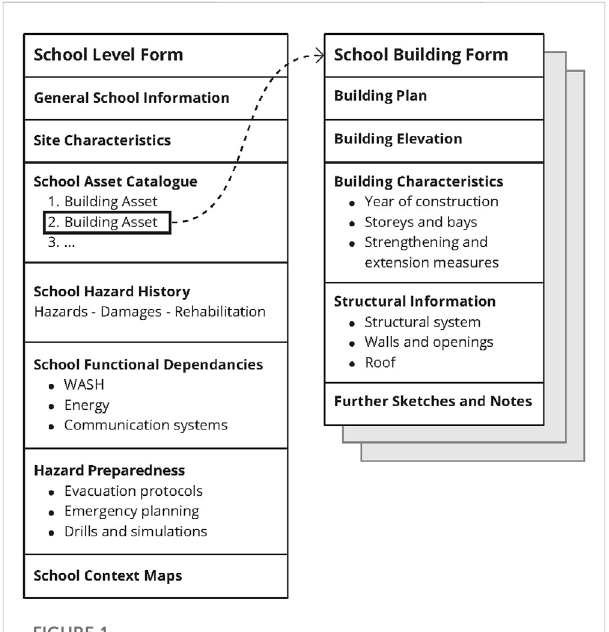
FIGURE 1 Engineering survey forms for schools exposed to